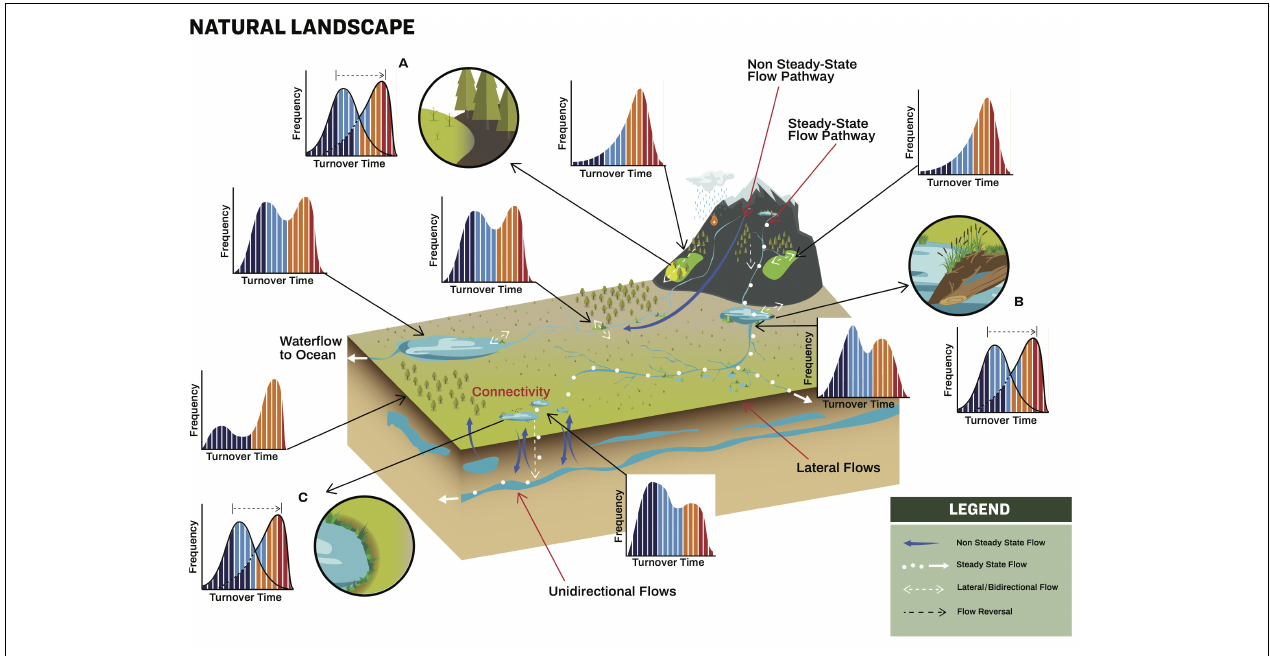
FIGURE 1 | Organic matter pathways across a landscape with natural structures. Different flows across the landscape are depicted along with frequency histograms of turnover. The colors within the histograms refer to the relative spatio-temporal impacts on turnover (see Table 1 and Figure 4 ). Insets (A–C) highlight the impact of transitions between different ecosystems and how the turnover rates change as OM is transferred from one to